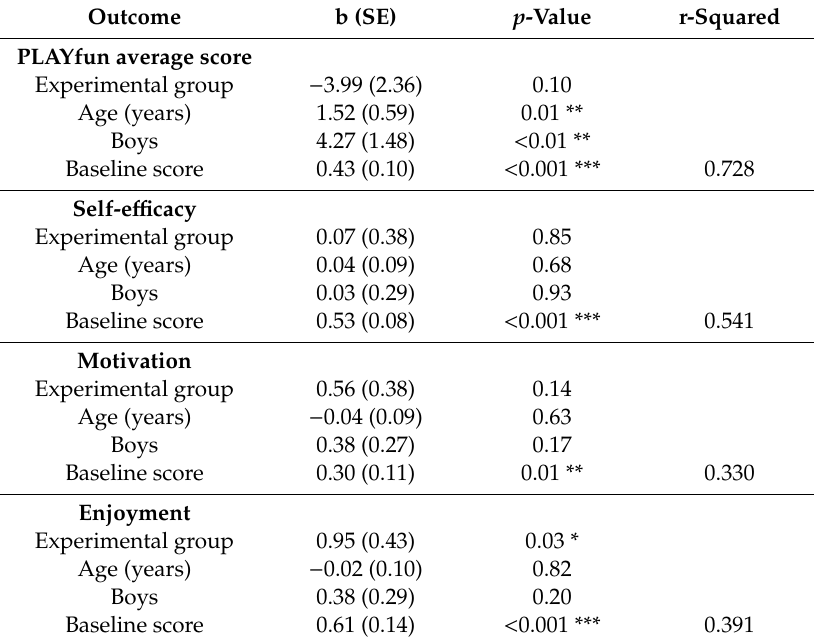
Table 5. Intervention e ff ects on motor competence, cognitive, and a ff ective outcomes.